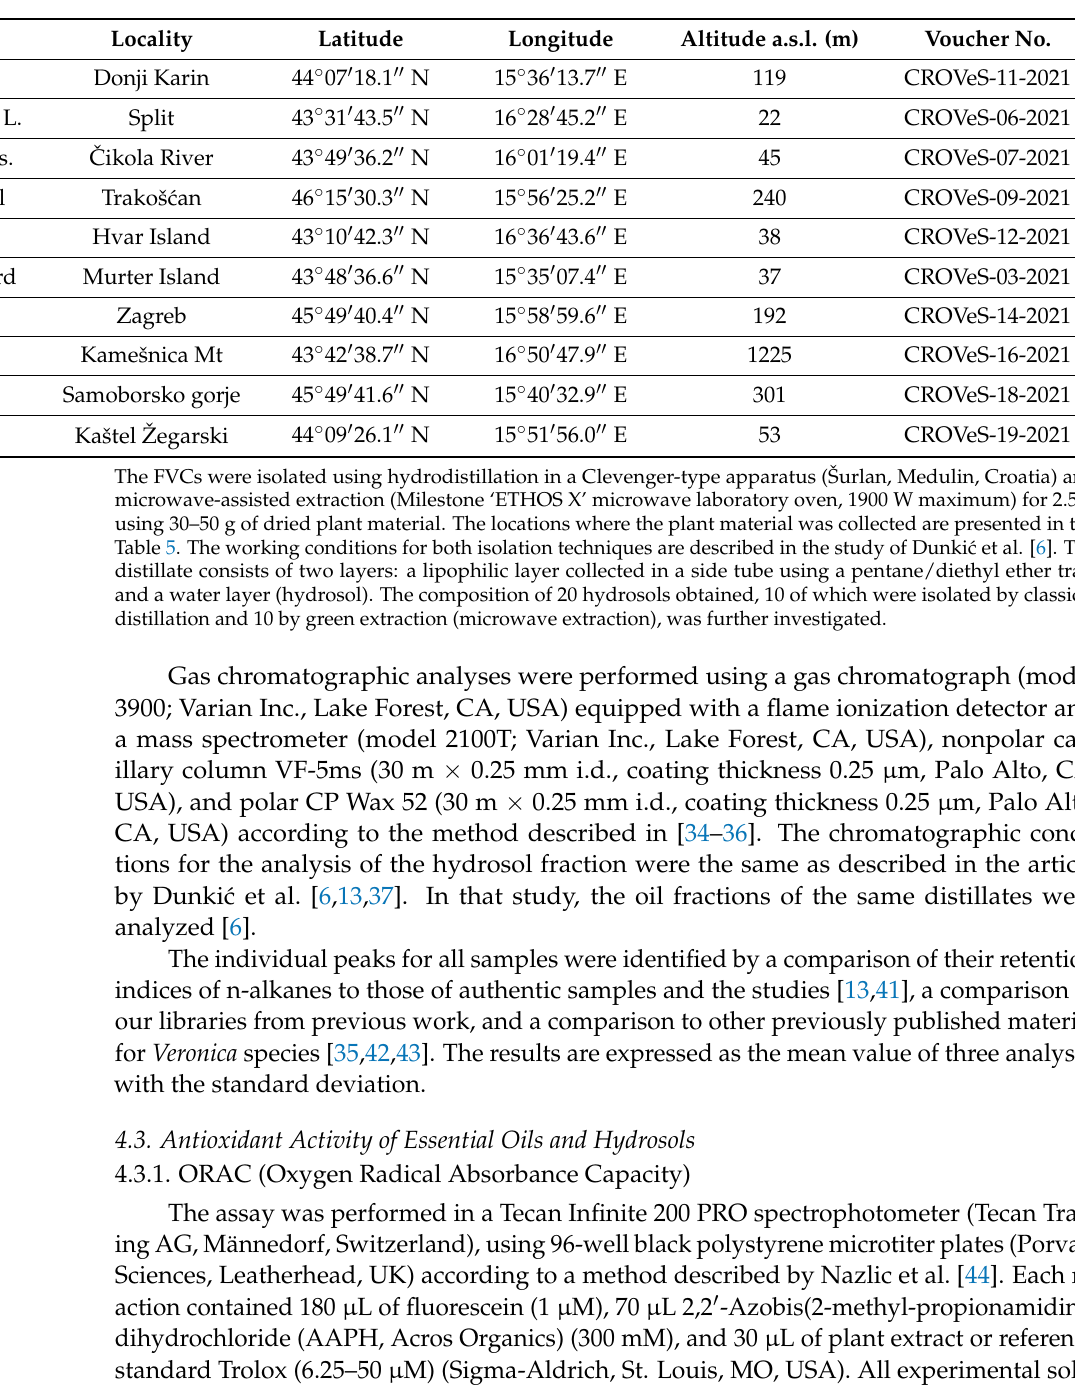
Table 5. Details of the data collection and origin of the investigated 10 Veronica